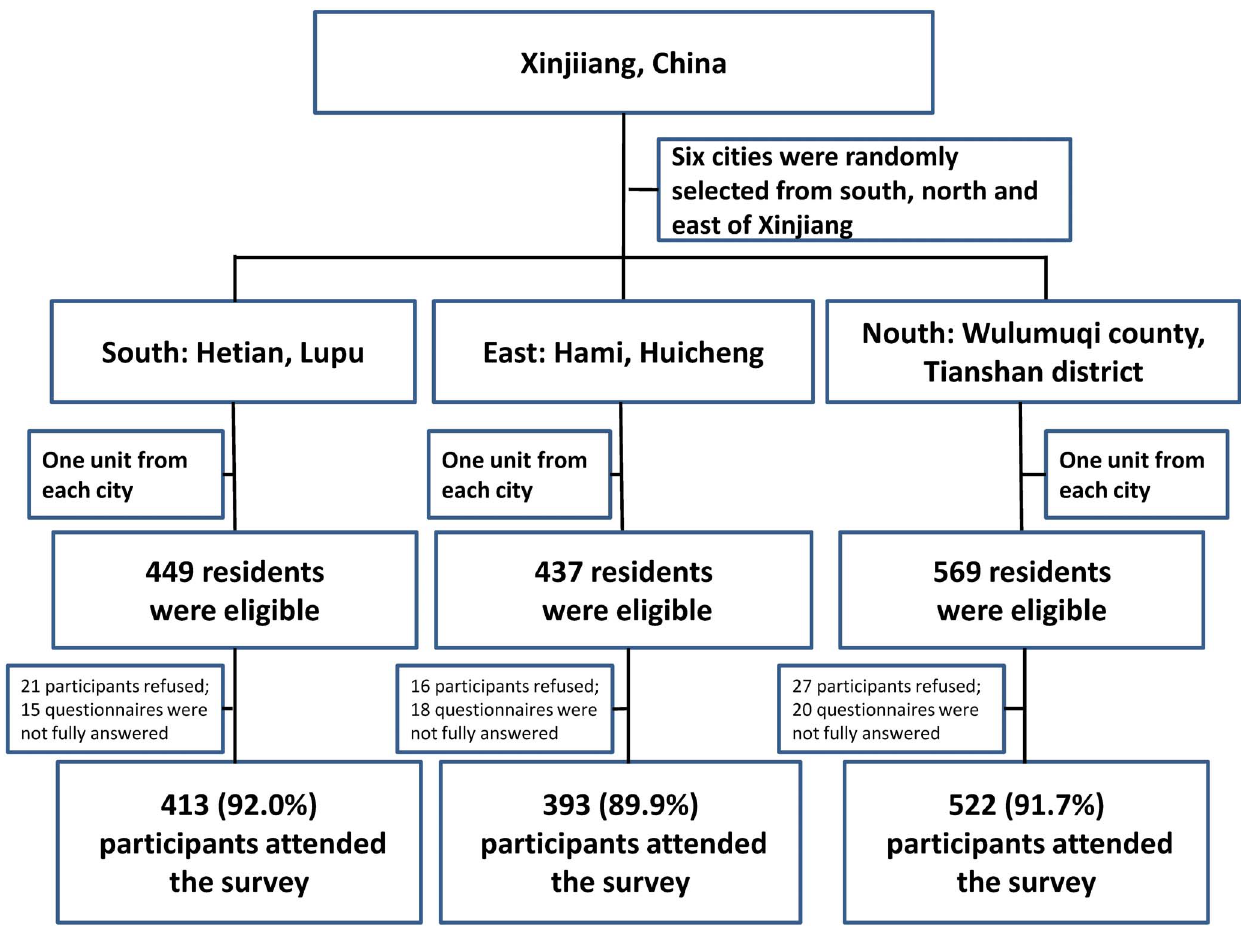
Figure 1. Flow Chart of the recruitment of the elderly Uyghur in Xinjiang Uyghur Autonomous Religion, China (N=1329), 2011.